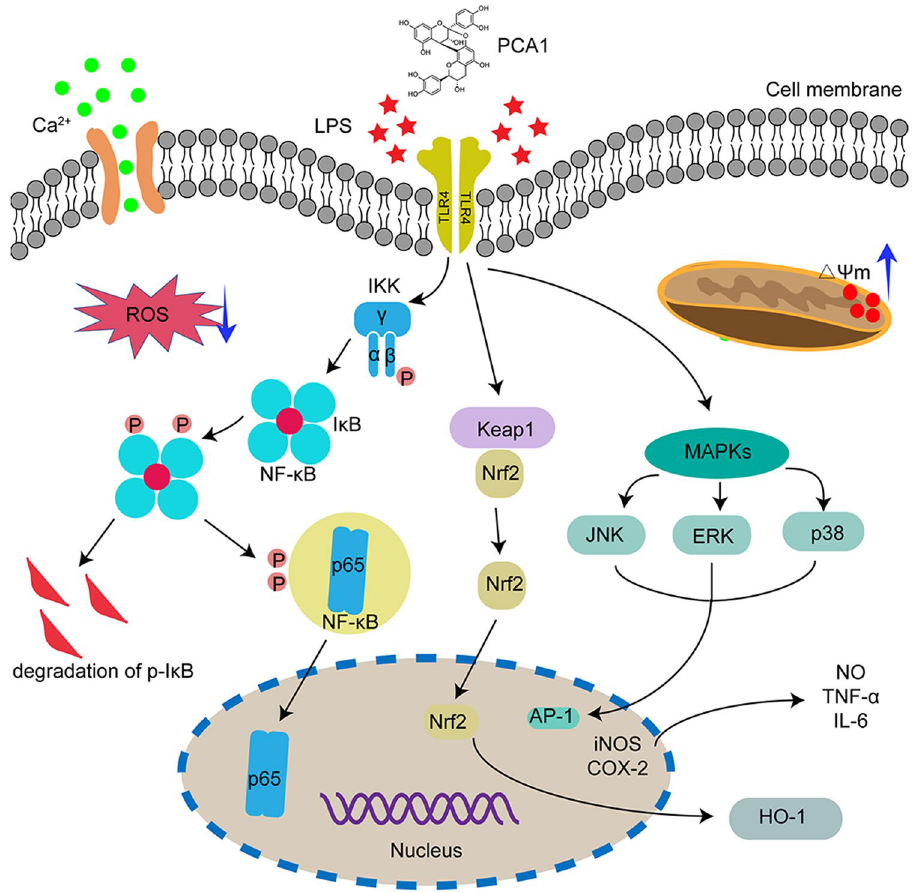
Figure 9. The schematic of the anti-inflammatory activities of procyanidin A1 in vitro . Procyanidin A1 (PCA1) exerts anti-inflammatory activity, which decreases calcium exclusion, reactive oxygen species (ROS) generation, and the release of pro-inflammatory cytokines through NF-kB, MAPK, and Nrf2/HO-1pathways. LPS, lipopolysaccharides; TNF- α , tumor necrosis factor- α ; NO, nitric oxide; COX-2, cyclooxygenase-2; iNOS, inducible nitric oxide synthase; NF- κ B, nuclear factor- κ B; IL-6, interleukin-6; MAPK, mitogen-activated protein kinase; JNK, c-Jun N-terminal kinase; ERK, extracellular regulated protein kinase; ROS, reactive oxygen species; Nrf2, nuclear factor erythroid 2-related factor; HO-1, heme